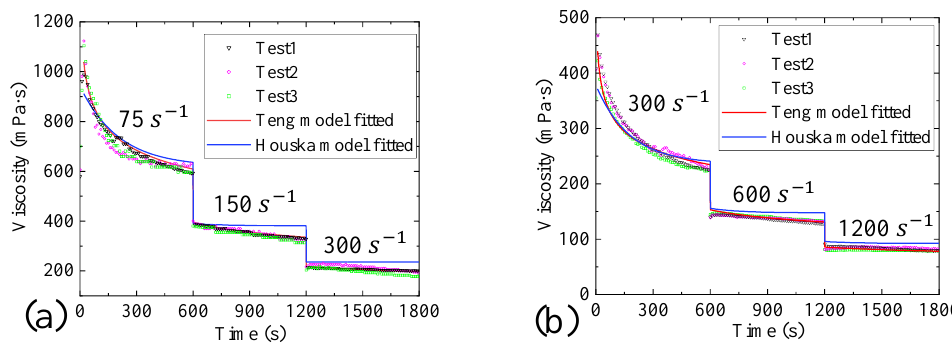
Figure 5. Measurement and prediction curve of the gel viscosity change under the step – shear rate under viscosity of ( a ). 75 s − 1 , 150s − 1 and 300 s − 1 ; ( b ). 300 s − 1 , 600s − 1 and 1200 s − 1 .